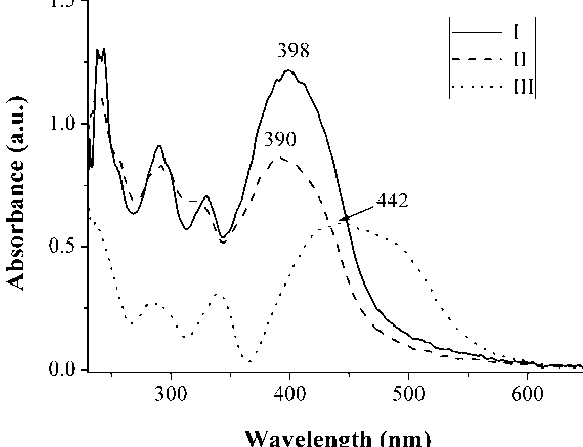
Figure 2. Absorbance in the solid state for compounds I , II , and III